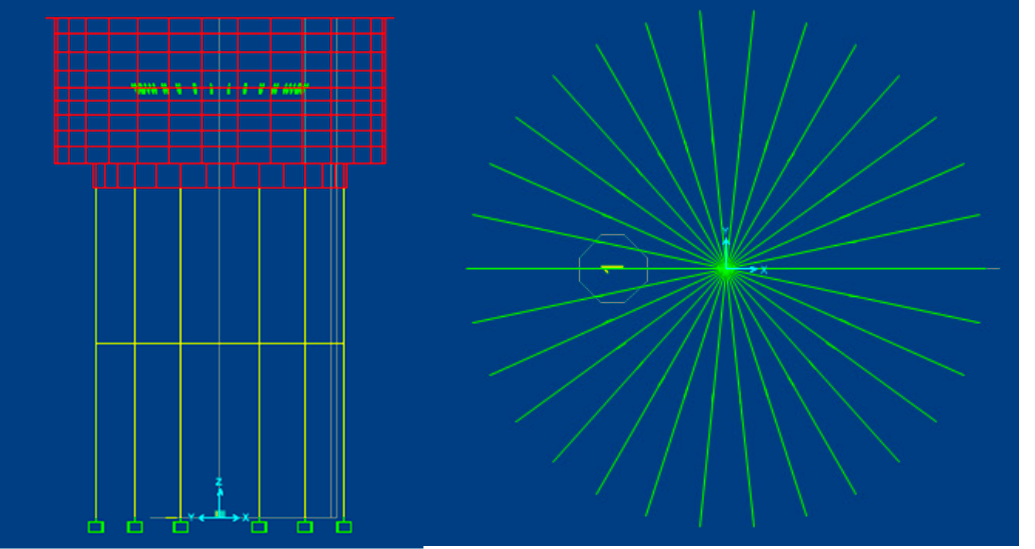
Figure 5. Spring mass model, convective mass attached to tank wall through link and impulsive mass rigidly attached to the tank